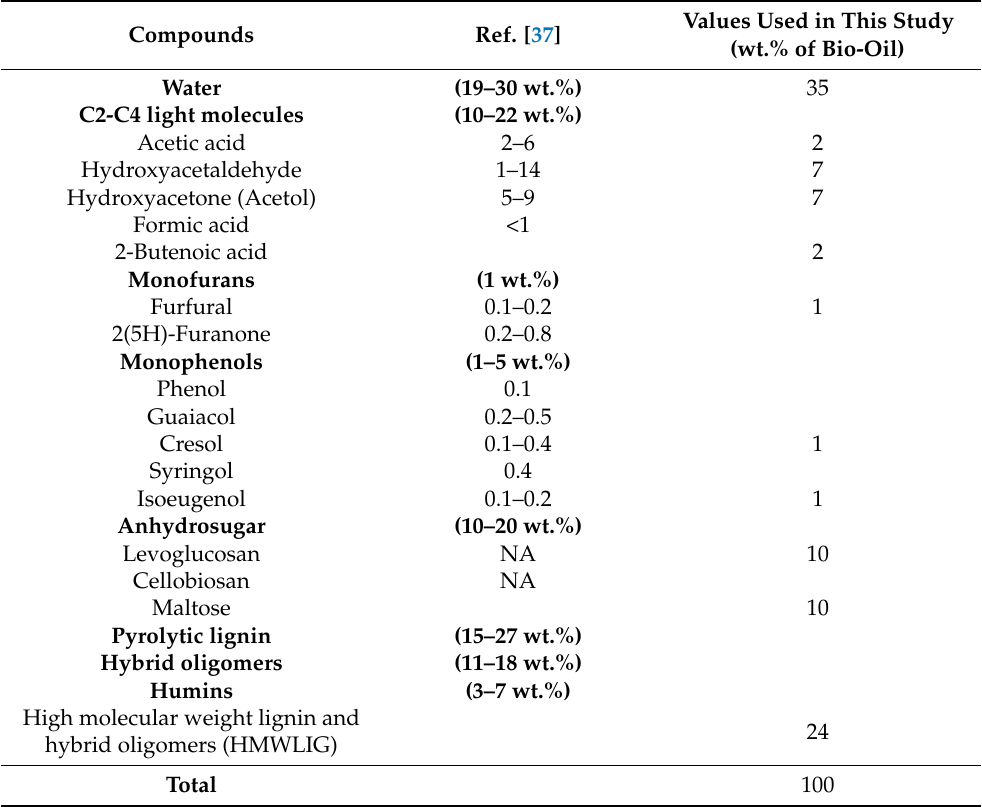
Table 3. Pyrolysis liquid compositions used in this work. Compounds Ref.